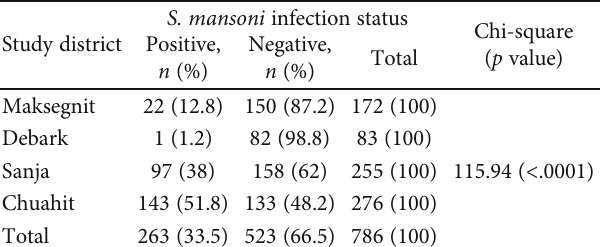
Table 2: Prevalence of S. mansoni in schoolchildren among study sites in Northwest Ethiopia, 2018.